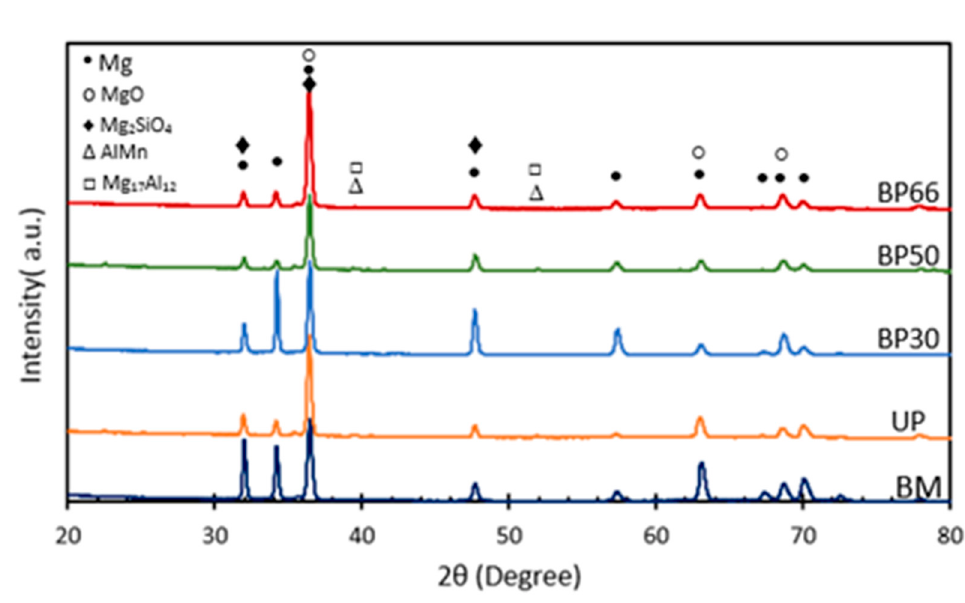
Figure 4. XRD patterns of the AM60 substrate before and after coating at different conditions.